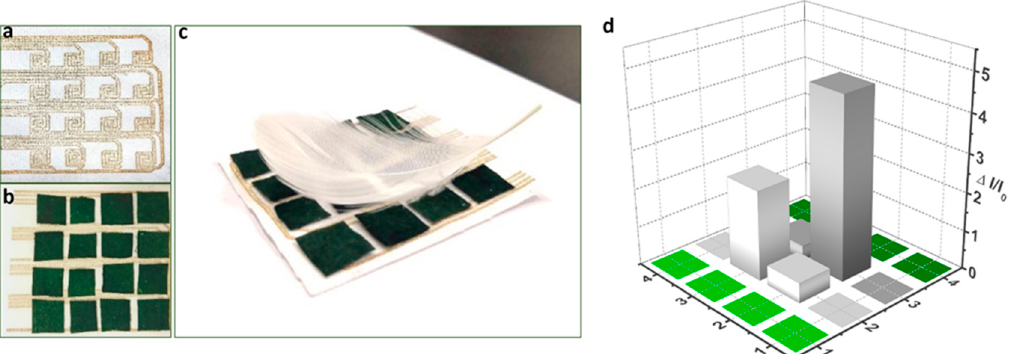
Figure 7. Pressure mapping by the PANI-based pressure sensing arrays. ( a ) a screen-printed sensor array with 4 × 4 pixels; ( b ) A photograph of the sensing array; ( c ) The sensing array pressed with a feather; ( d ) 3D bar graph showing the real-time relative current change.